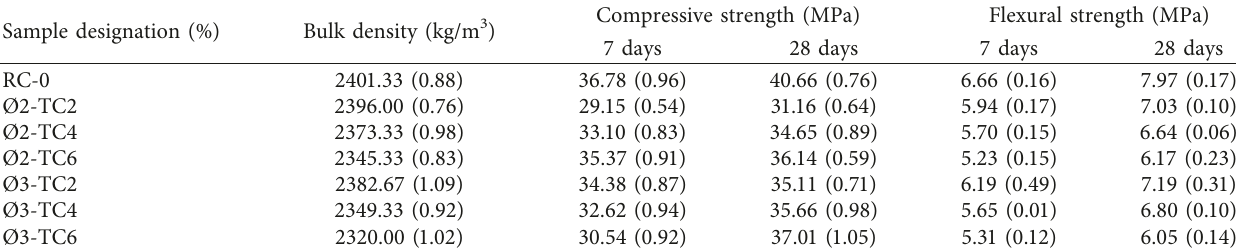
Figure 3: Experimental test setup. Table 7: Mechanical properties of translucent concrete